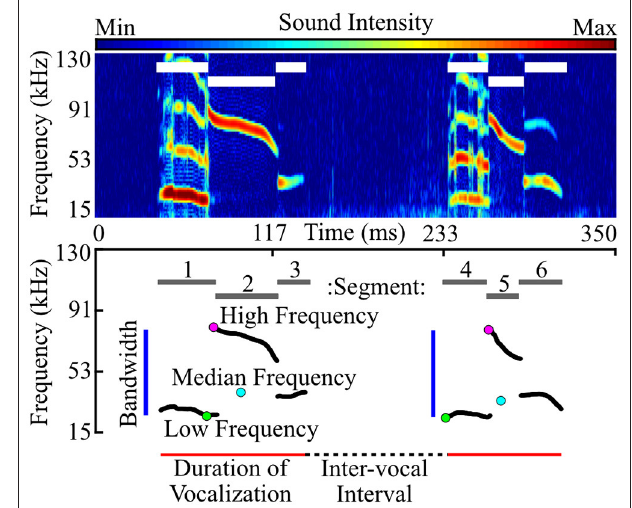
FIGURE 2 | Vocal features were characterized by generating a fundamental frequency contour of each vocalization. Using recorded audio data (represented as a spectrogram; top), we extracted vocal segments, or continuous units of sound (white lines in top image show segment duration, corresponding to gray lines in bottom). Each segment was represented by its fundamental frequency contour (bottom; black lines), tracing the fundamental (lowest) frequency at each time point. Note that harmonics (frequencies at integer multiples of the fundamental) are not represented in the fundamental trace. Segments separated by 40ms or less were then consolidated into vocalizations (bottom; red lines show duration), and the corresponding segment contours were collapsed to generate a single contour for each vocalization. Contours were used to characterize the acoustic features of each vocalization, as represented above. Inter-vocal interval is the time between two successive vocalizations. High, median, and low frequency are the highest, median, and lowest frequency within each fundamental contour, respectively. Bandwidth is the frequency range, or high frequency minus low